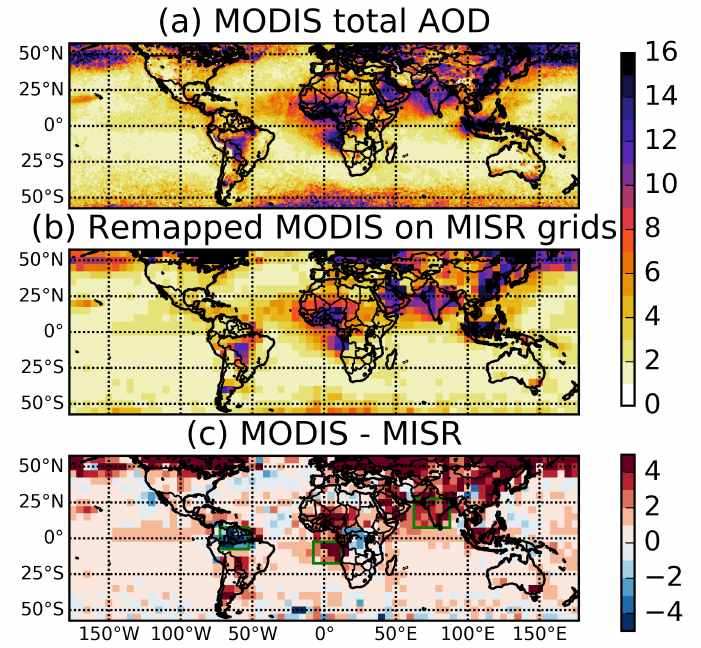
Figure 4. ( a ) The minimum record lengths required to obtain stable annual mean climatology of total AOD from MODIS within the accuracy level of ± 0.01 AOD. ( b ) Same as ( a ) but the MODIS AOD dataset was remapped on MISR JOINT_AS’ grid points. ( c ) The difference of the minimum record lengths in ( b ) with those from MISR in Figure